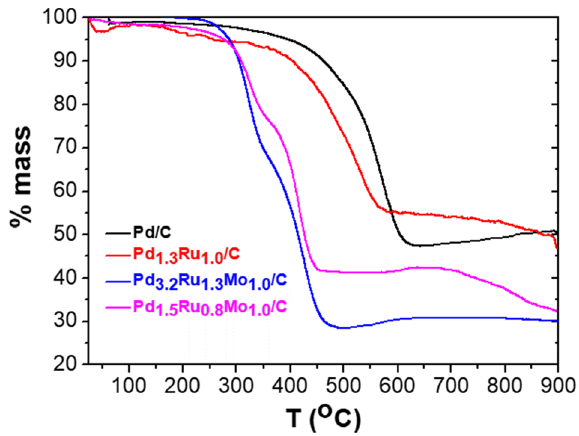
Fig. 2 - XRD patterns of a Pd/C, b Pd and d Pd 1.5 Ru 0.8 Mo 1.0